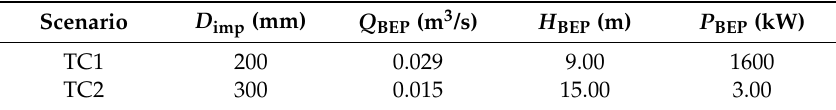
Table 1. PATs characteristic in turbine